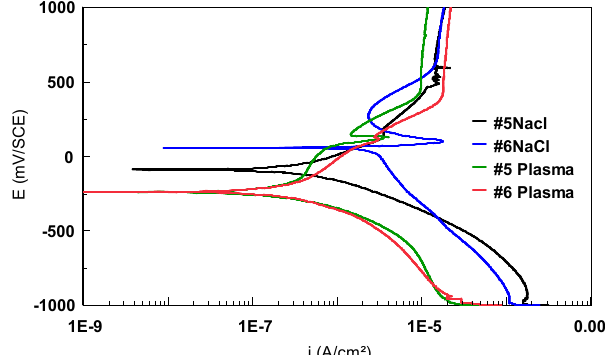
Figure 18. Potentiodynamic polarization curves recorded for the Ti6Al4V scaffold samples in 9 g/L NaCl and artificial plasma bone (semi-logarithmic scale).